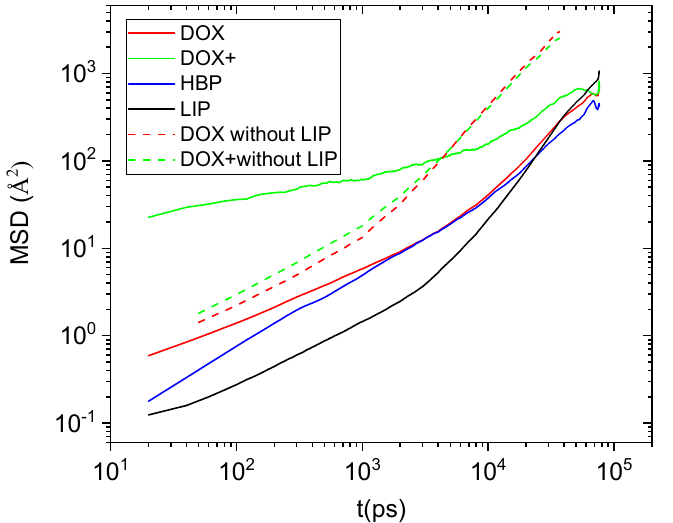
Figure 11. Mean square displacement arising from the center of mass of the drug molecules, the hyperbranched polyester, and the bilipid membrane (considered as a single moiety including all the lipids). The behavior of the drug molecules in the membrane-free case is also shown for comparison purposes.